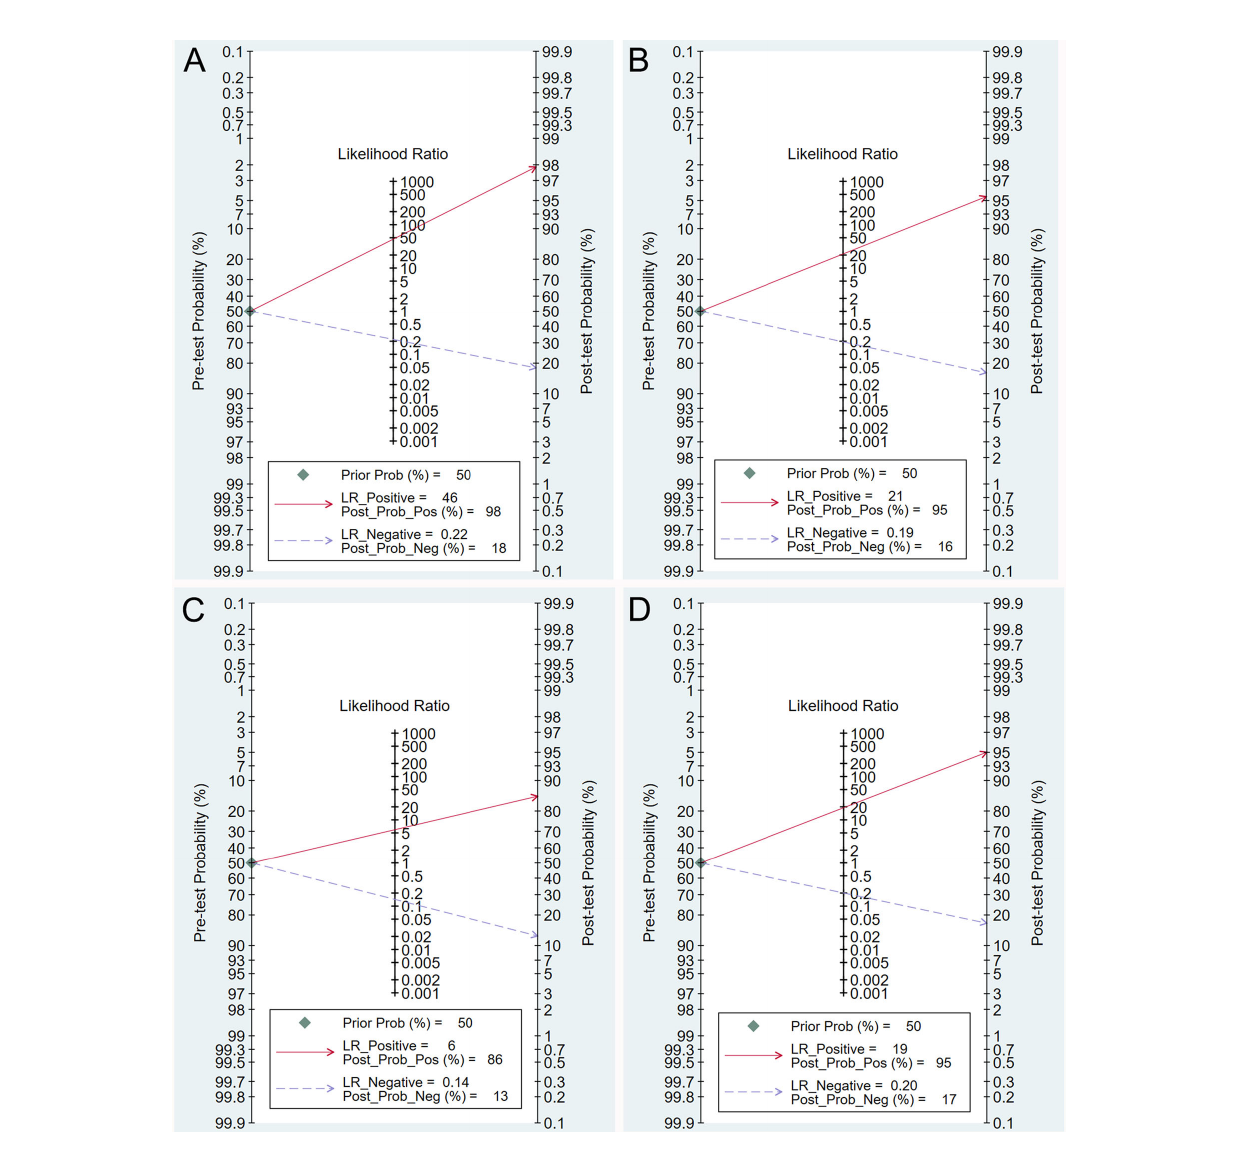
FIGURE 4 | Fagan plot estimating how much the result of double contrast-enhanced ultrasonography changes the probability that a patient has a T1 (A) , T2 (B) , T3 (C) , or T4 (D) gastric cancer, considering a given pre-test probability (here the mean pre-test probability found in eligible studies is shown as an